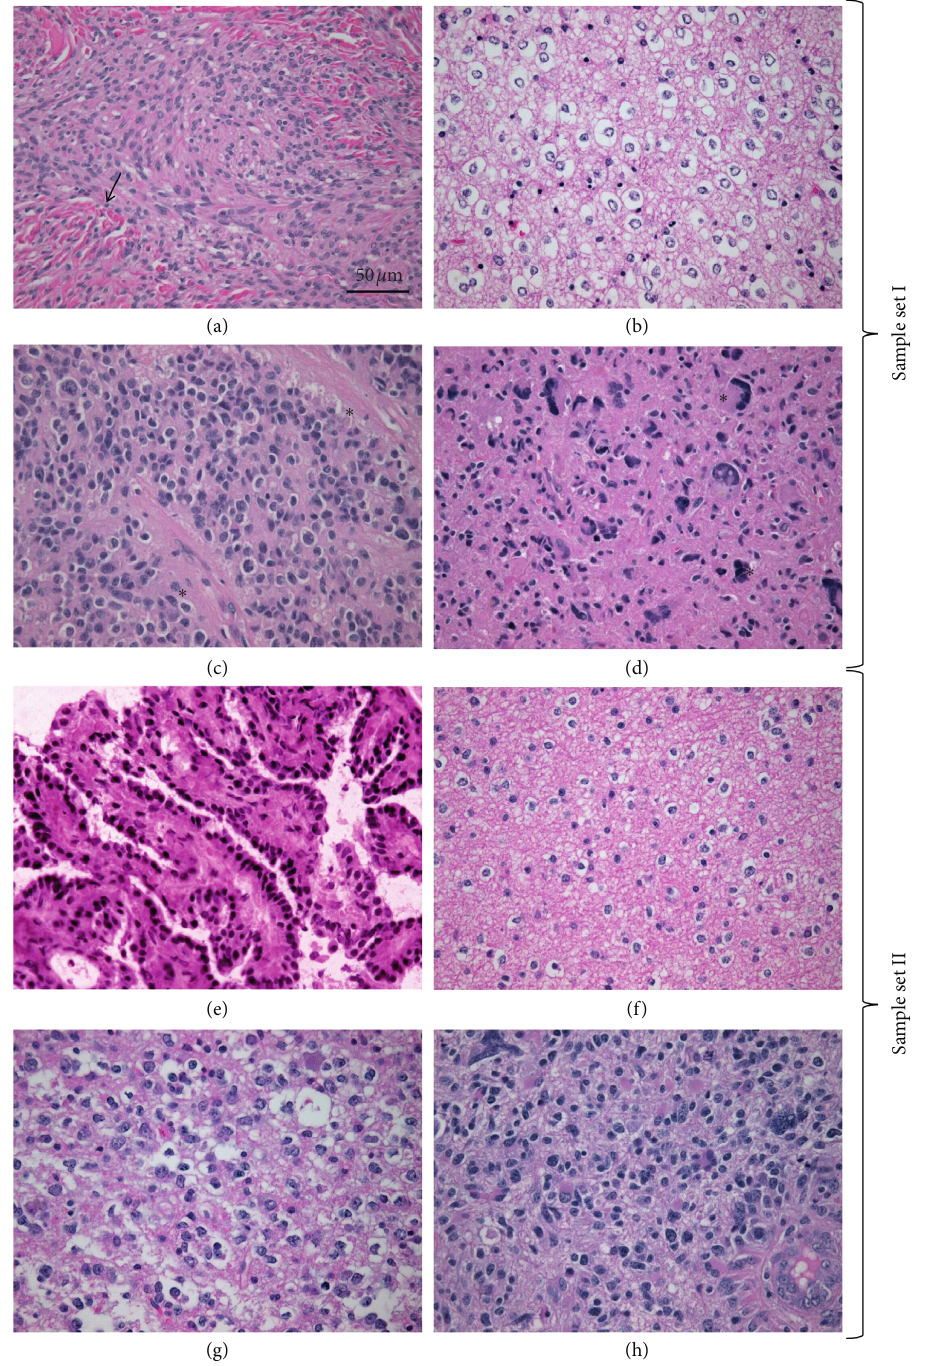
Figure 1: Histological features of brain tumour tissues used for spectroscopic analyses (H&E staining). (a) fibrous meningioma (WHO grade I sample (A)) with isomorphic tumour cells and eosinophilic collagen fascicles (arrow); (b) low-grade oligodendroglioma (WHO grade II, sample (B)) presented with the typical honeycomb pattern of tumour cells with isomorphic nuclei. Single cells resemble fried eggs with blue yolk (nucleus); neither mitosis nor vascular proliferations are detectable. (c) anaplastic ependymoma (WHO grade III, sample (C)) is a cellular neoplasm with prominent perivascular pseudorosettes (asterisks) and increased proliferation; (d) glioblastoma (WHO grade IV, sample (D)) is characterized by polymorphous tumour cells, some of which are multinucleate (asterisks), by mitotic activity and by prominent vascular proliferation. (e) plexus papilloma (WHO grade I sample (E)) presented with typical papillary architecture, iso- morphous tumour cells, and nuclei; no mitoses are detectable; (f) low-grade oligodendroglioma (WHO grade II, sample (F)) with the characteristic honeycomb pattern (similar to Figure 1(b)); (g) features of anaplastic oligodendroglioma (WHO grade III, sample (G)) consists of a honeycomb pattern similar to low-grade oligodendroglioma, higher cellularity, and pleomorphic nuclei and occasional mitoses (arrow); (h) glioblastoma (WHO grade IV, sample (H)) as a highly cellular and polymorphous glial tumour with vascular proliferation (arrow) and multinucleated cells. Scale bar in (a) is valid for (a)–(h), 50 μ